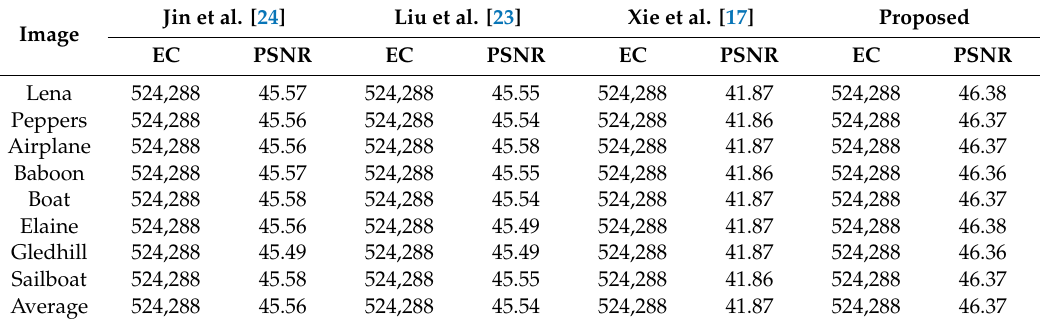
Table 3. Comparison with related works.